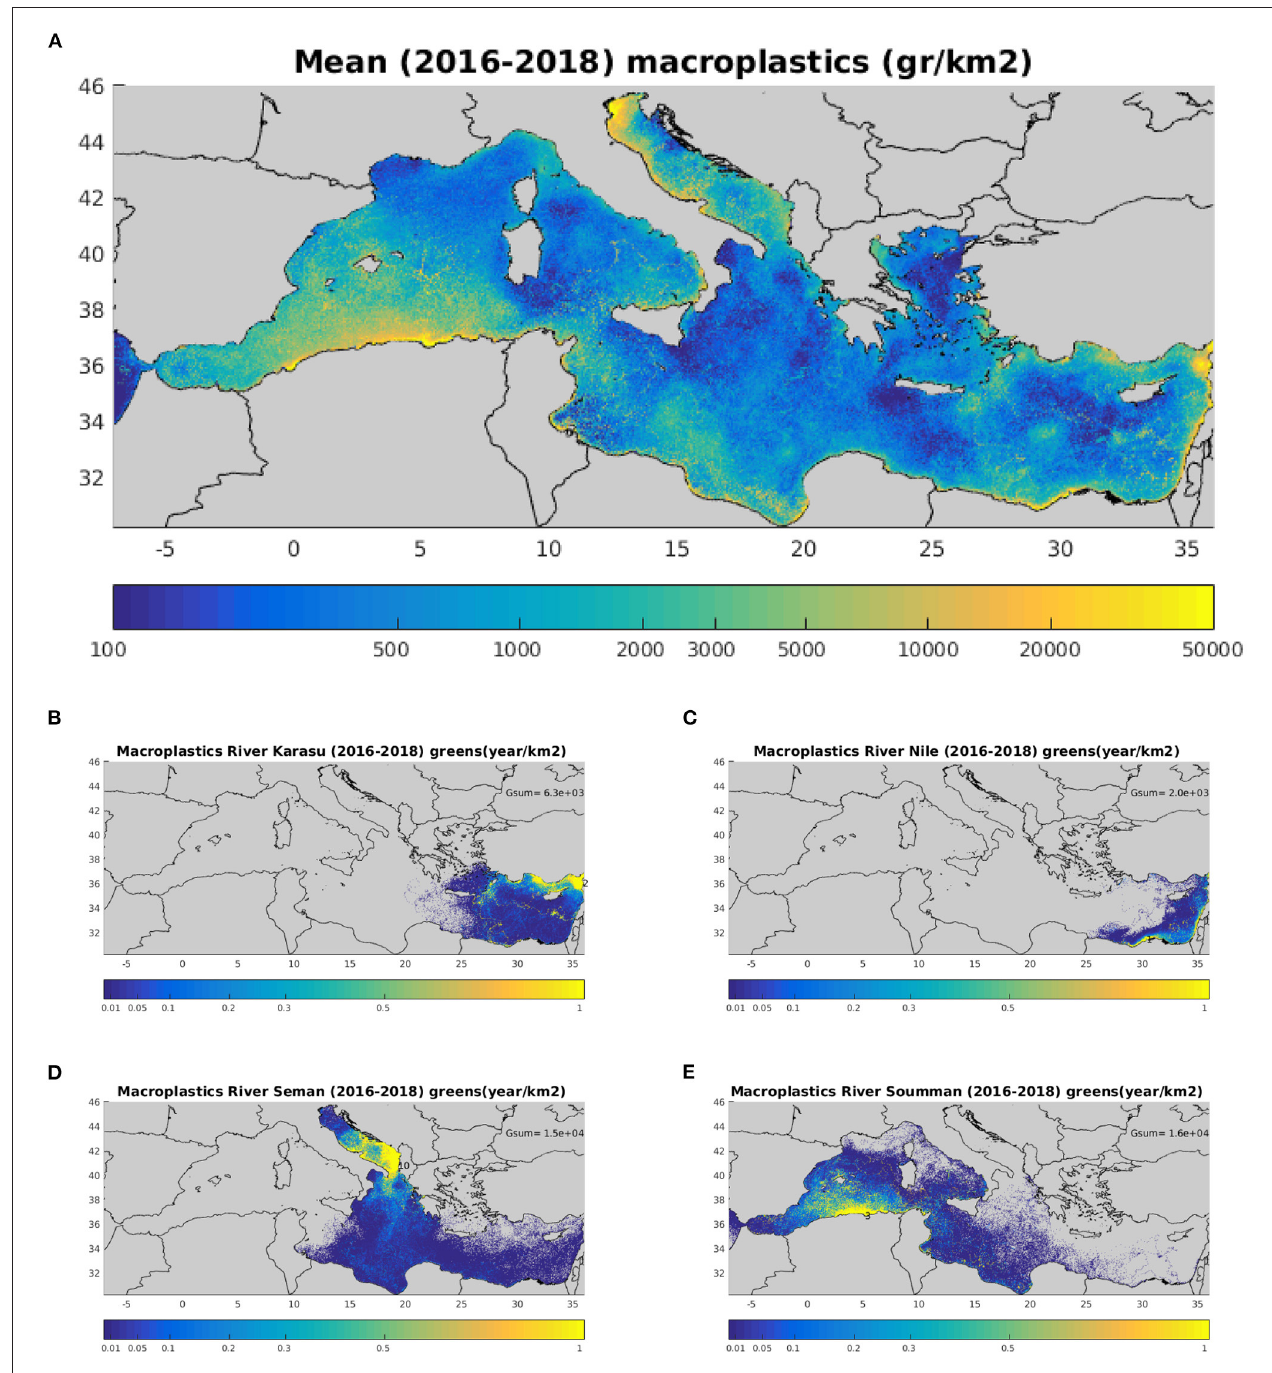
river pollution is particularly low, according to the adopted (Lebreton et al., 2017) dataset; further source mapping suggests that river pollution accounts for a relatively smaller fraction of the macrolitter input in the Mediterranean Sea. Actually, it turns